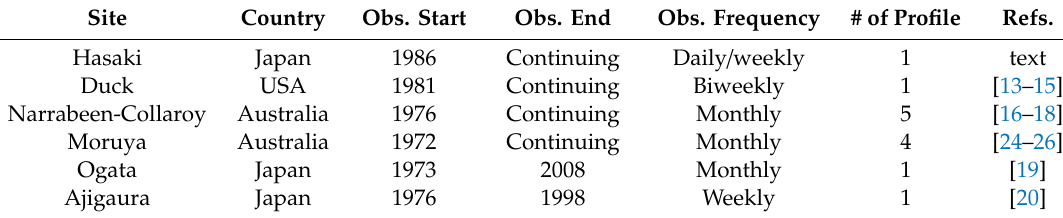
Table 1. Examples of long-term beach observation studies,